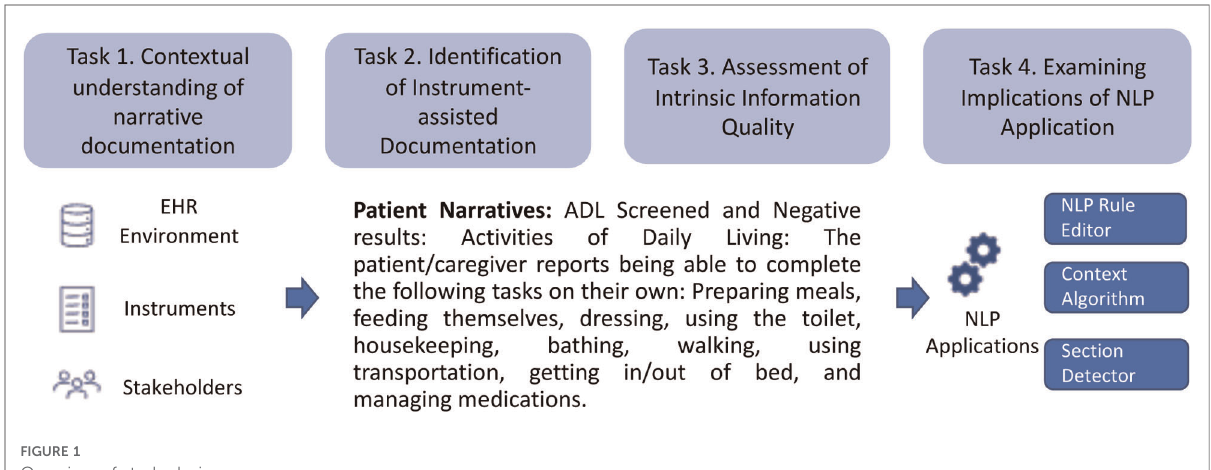
FIGURE 1 Overview of study